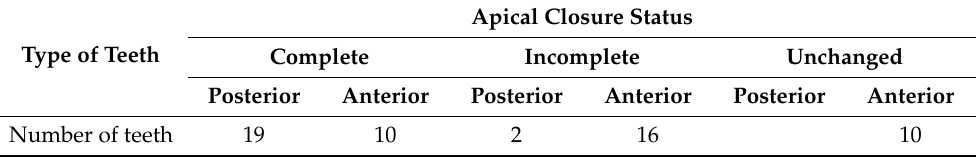
Table 2. The distribution and frequency of apical closure